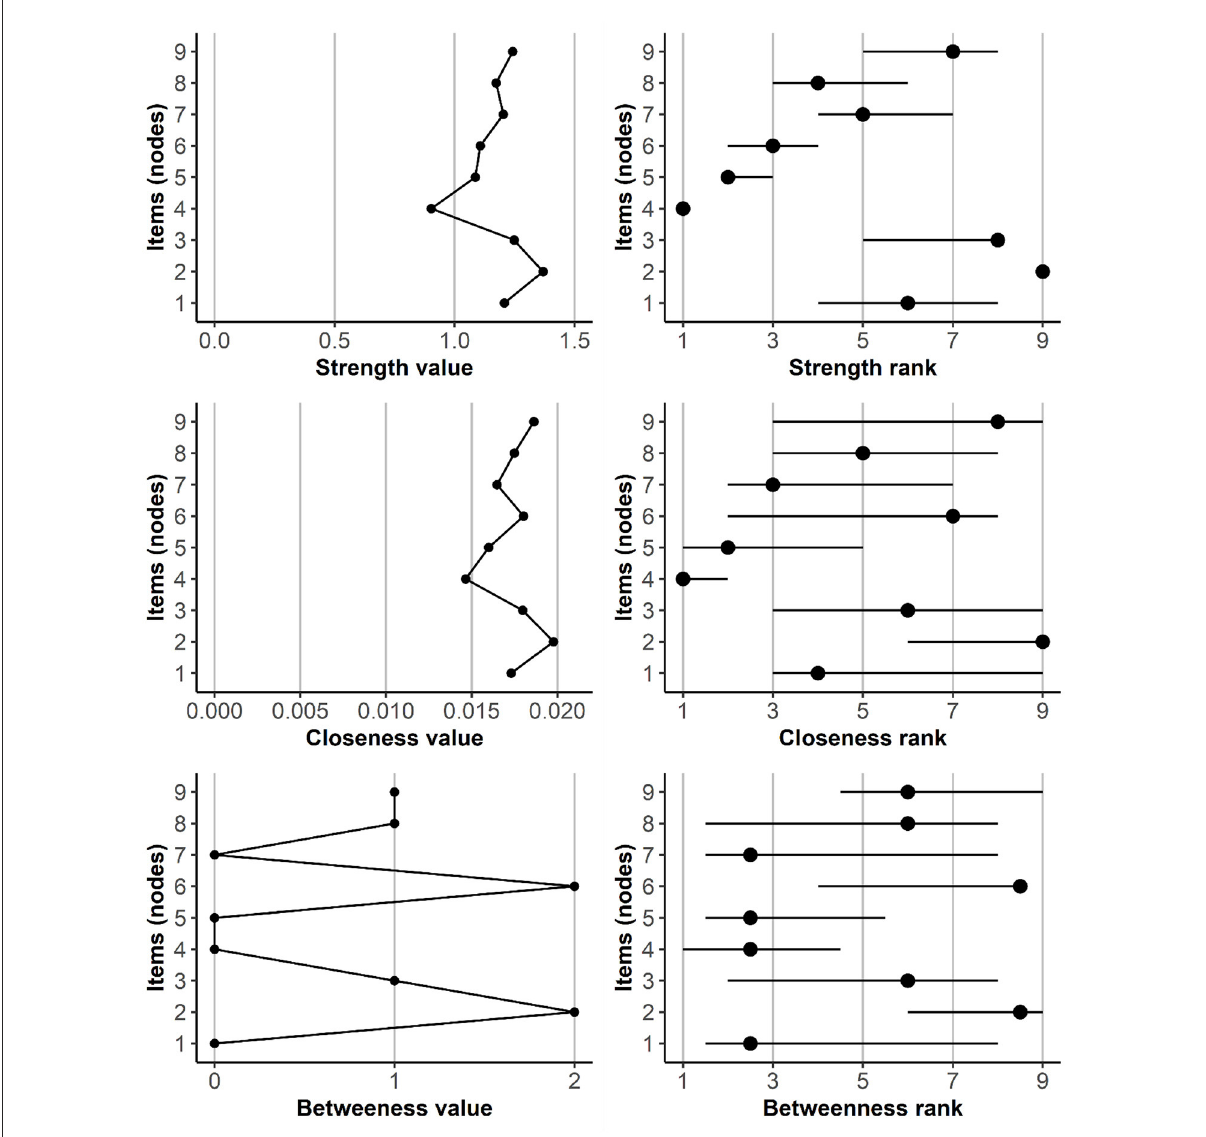
FIGURE4 Values of centrality indices and node ranks, with 99.5% confidence intervals. Item (node) numbers indicate: 1 = Preoccupation, 2 = Tolerance, 3 = Withdrawal, 4 = Persistence, 5 = Displacement, 6 = Problem, 7 = Deception, 8 = Escape, and 9 = Conflict.